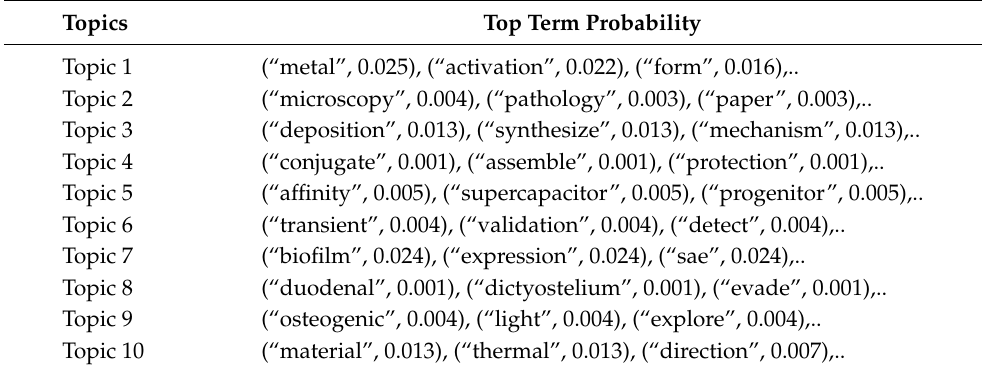
Table 2. A list of the topics for modeling bioengineering document